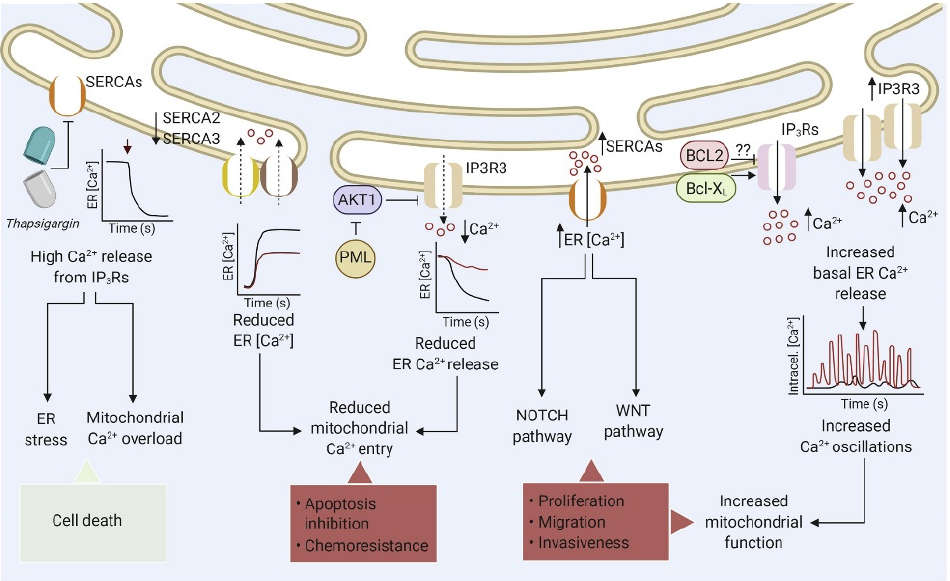
Figure 2. Cancer-associated defects of endoplasmic reticulum Ca 2+ homeostasis. Reproduced with permission from ref [51]. Copyright Elsevier 2020. Table 1. Ion-channel blockers and chelators that are drug candidates in clinical trials against cancer.